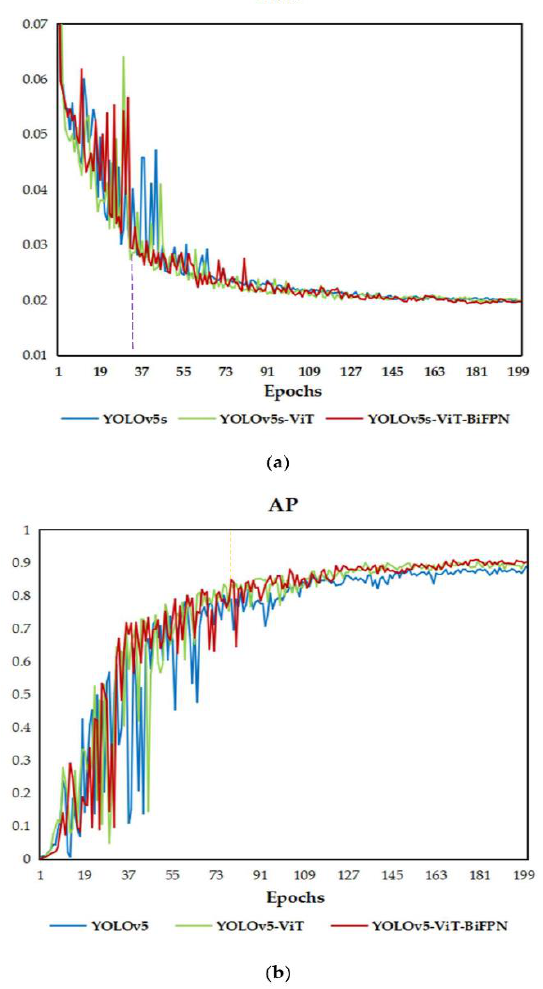
Figure 12. Comparison of change curves of the loss function and AP for 3 models: ( a ) Change curve of loss function and ( b ) change curve of AP.